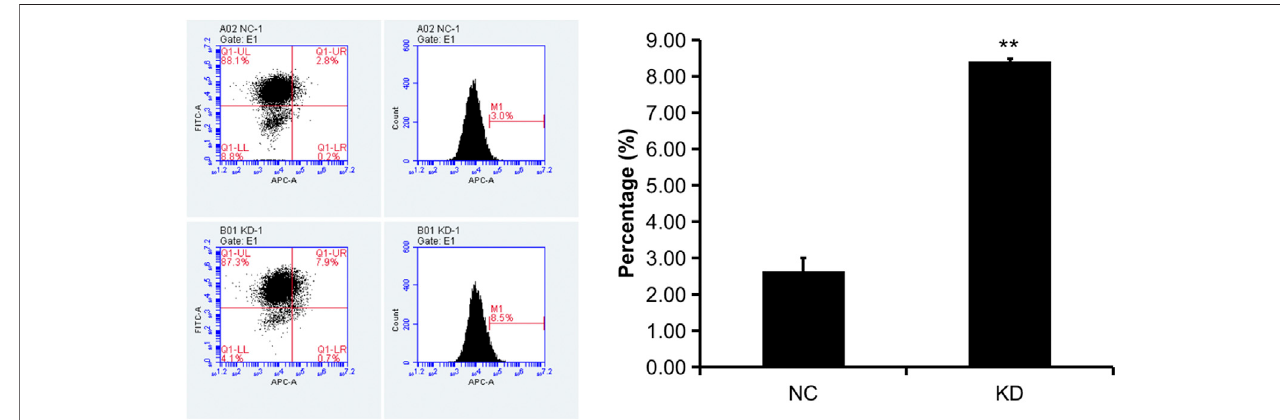
FIGURE13| FlowcytometryapoptosisanalysisofHBVSMCstransfected withcontrolorhsa_circ_0005505shRNAs.KD (cid:1) knockdownofhsa_circ_0005505,NC (cid:1) negative control. * p < 0.05, ** p < 0.01, *** p < 0.001.